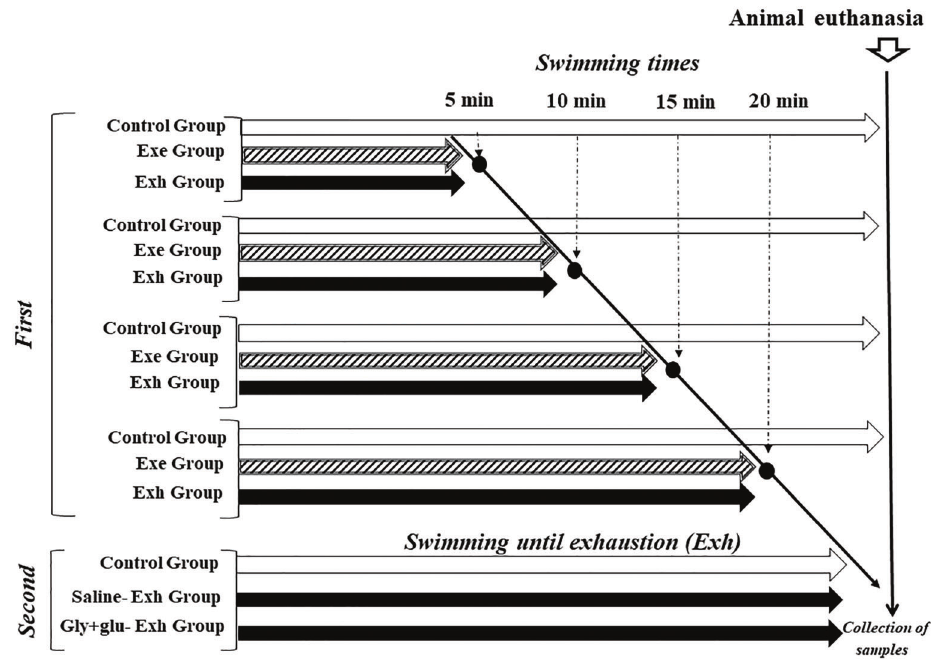
Figure 1. Design of the fi rst and second experimental protocols. The control group was immediately removed from the tank. The exhausted (Exh) group was left until exhaustion, and the Exe group was immediately removed from the water at the same time as Exh. In the second experiment, the animals received oral (gavage) saline (1 mL) or 0.63 g/kg b.w. glycerol (Gly) + 0.25 g/kg b.w. glucose (glu), 20 min before starting the strenuous swimming